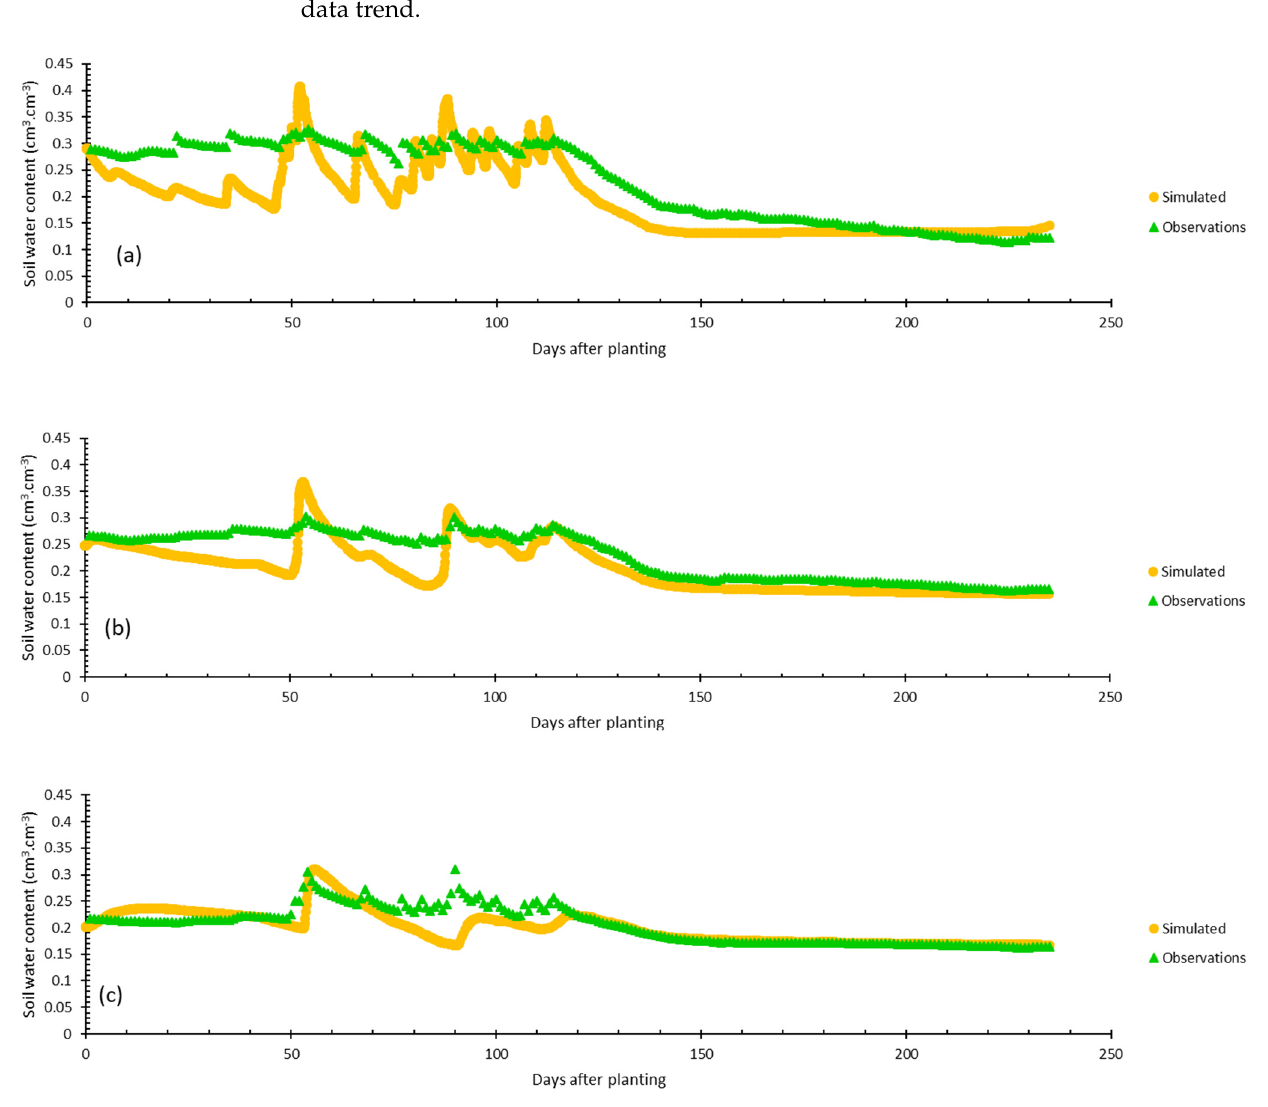
Figure 7. The simulated and observed soil water content at ( a ) 16, ( b ) 46, and ( c ) 76 cm soil depths. Similar performance of the model was observed for ECsw simulation. The discrep- ancies between observations and simulated were not noticeable for salinity simulations. However, some noticeable deviations were detected between simulated and observed ECsw values at 76 cm soil depth, which was expected as another source of uncertainty detected for this soil depth in the analysis of the model predictive